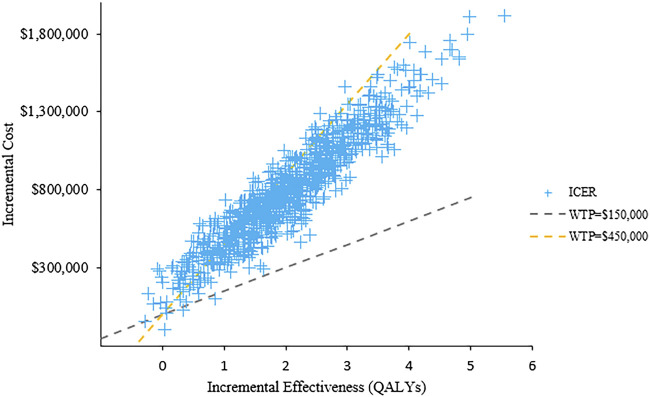
Scatter plot of probabilistic sensitivity analysis. ICER: incremental cost-effectiveness ratio; WTP: willingness to pay.